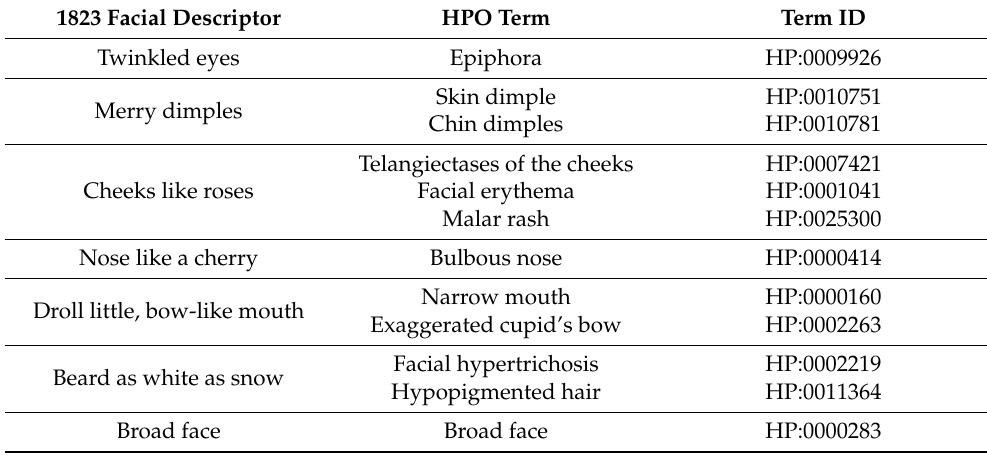
Table 1. Facial descriptors of Father Christmas from 1823 and possible corresponding HPO